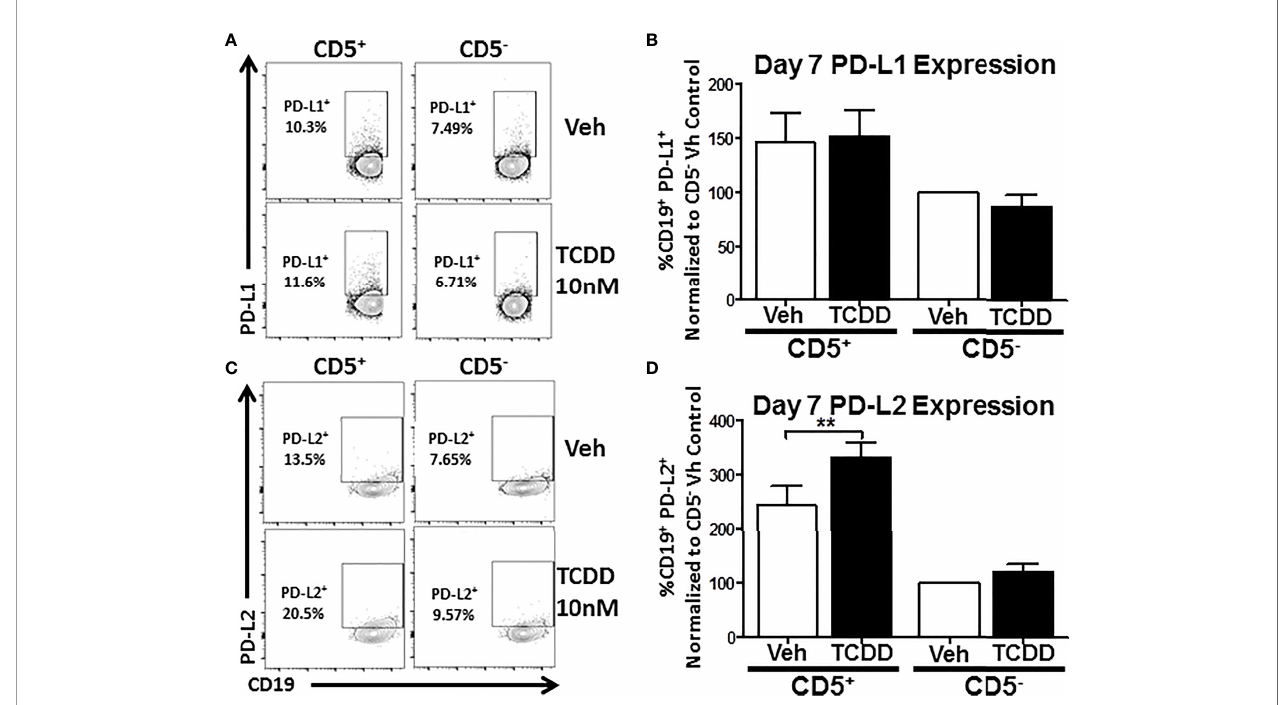
FIGURE 4 | TCDD treatment of human CD5 + B cells signi fi cantly increases the frequency of PD-L2 cell surface protein positive cells. Human CD5 + and CD5 - B cells were isolated, activated, and treated with TCDD (10nM) for 7 days as previously described. After the culture period, cells were collected and surface stained with anti-PD-L1 and PD-L2 antibodies and cell surface protein expression was quanti fi ed by fl ow cytometry. Representative fl ow plots for Veh and TCDD treated CD5 +/- B cells are shown in panels (A, C) . PD-L1 + and PD-L2 + cells were identi fi ed in the lymphocyte, singlet gate by gating on live CD19 + cells. The frequency of PD-L1 and PD-L2 positive cells was normalized to CD5 - Veh control. Averaged data from 2 independent experiments assessing a total of 6 human donors are shown in panel (B) (PD-L1) and (D) (PD-L2). Signi fi cance was determined by a repeated measures two-way ANOVA with a Dunnett ’ s posttest. ** p